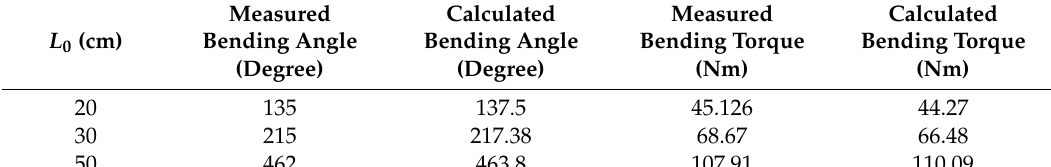
Table 4. The measured and calculated bending angle and bending torque of the three various SBCAs.